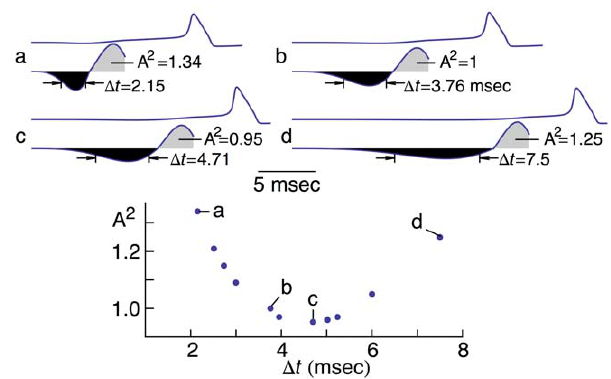
Figure 6. U-shaped dependence of firing on the half-width, D t , of the hyperpolarizing phase. [The D t variable is defined as the difference in time between the two points on the hyperpolarizing phase of the stimulus where the amplitude of the curve is one-half the maximum value of the hyperpolarizing current.] Eleven different values of b (Equation 5) were used (graph in bottom panel) with a in Equation 5 chosen to maintain constancy of value of the square of the area of the phase (shaded black). The depolarizing phase (shaded gray) was adjusted to be slightly suprathreshold as indicated by the simulations in the top panels for a – d . Panel b corresponds to the result in the middle panel of Figures 4 & 5. This is our standard optimal stimulus shape. During the analysis an increase in optimality relative to our standard shape was discovered as indicated by the values of A 2 in the graph that are less than 1. This parameter – A 2 – refers to the square of the grey shaded areas in a – d , a result related to energy expenditure, as noted in the